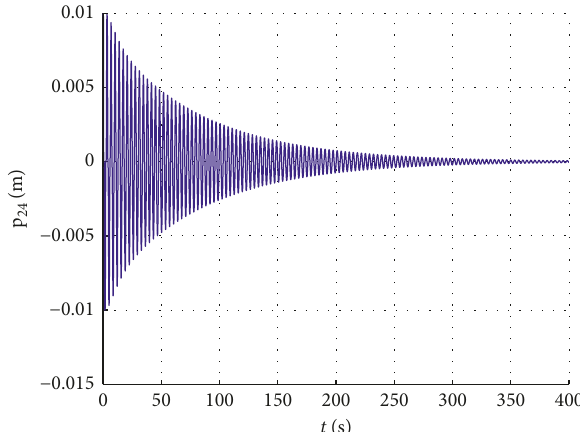
Figure 7: Initial condition displacement response of uncontrolled